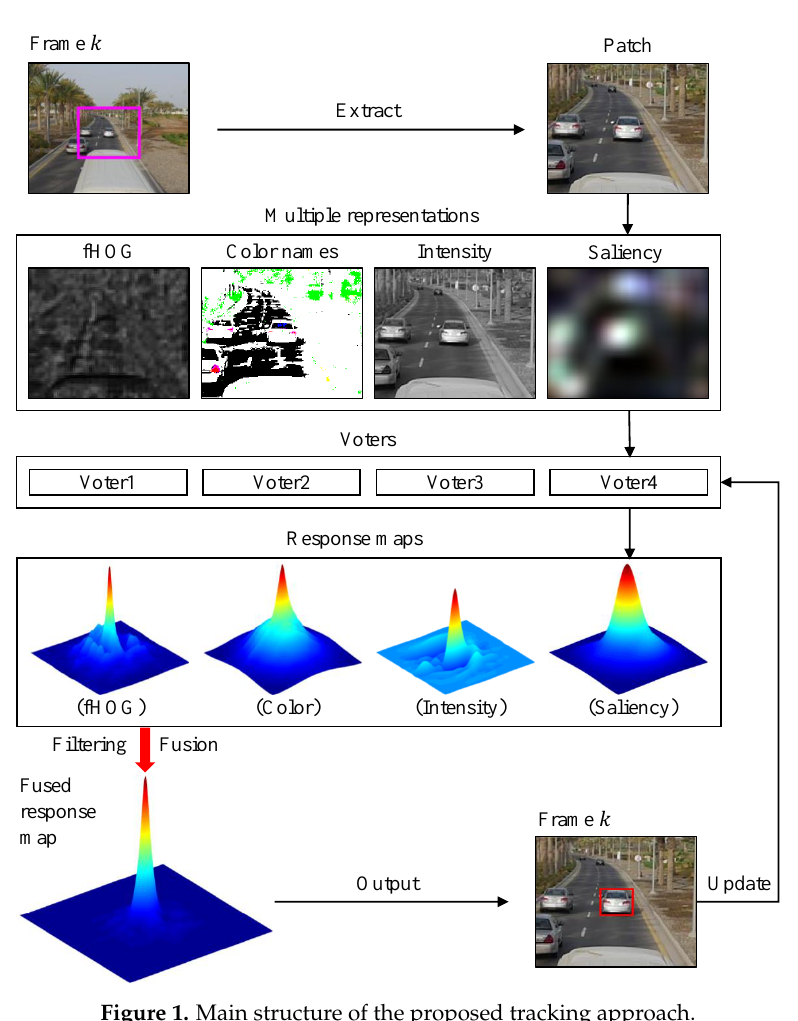
Figure 1. Main structure of the proposed tracking approach.